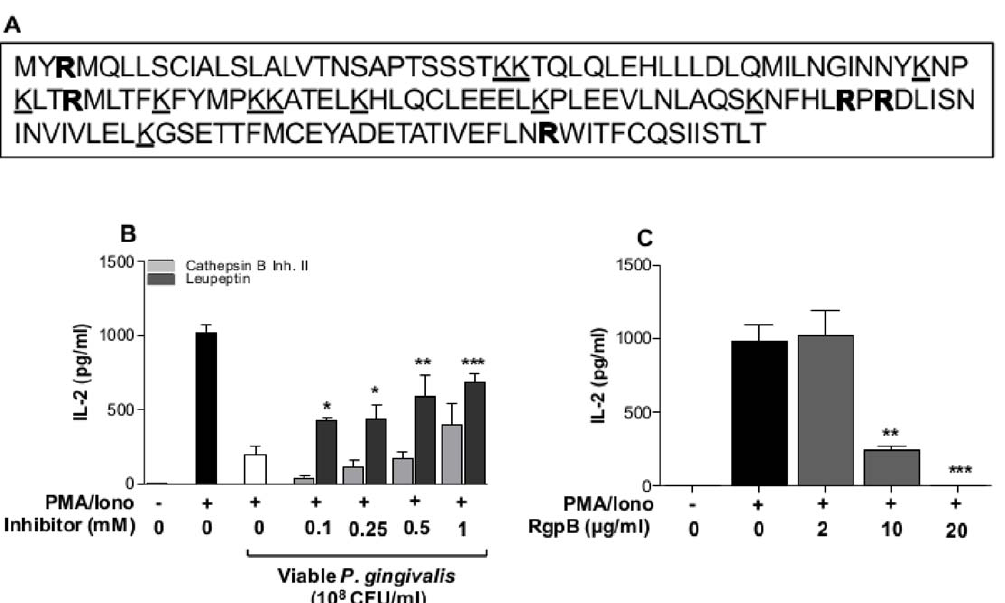
Figure 7. The proteinase inhibitor Leupeptin partially restored IL-2 accumulation. A - IL-2 amino acid sequence with predicted Rgp (bold)- and Kgp (underlined) cleavage sites. Five Rgp sites and 11 Kgp sites were found, source: http://www.ncbi.nlm.nih.gov/CCDS/CcdsBrowse. cgi?REQUEST=CCDS&DATA=CCDS3726. B - The involvement of Rgp and Kgp in IL-2 cleavage was determined by using Cathepsin B inhibitor II and Leupeptin. Viable P. gingivalis were incubated with the indicated concentration for 1 h prior to exposure of cells. Jurkat T-cells (10 6 cells/ml) were pre- treated with 10 8 CFU/ml of viable P. gingivalis (MOI:100) for 1 h followed by stimulated with 50 ng/ml PMA and 1 m g/ml Calcium ionophore for 24 h. IL-2 accumulation was partially restored by Leupeptin, but not by Cathepsin B inhibitor. The asterisks indicate significant differences compared to their respective control (Viable Pg, without Leupeptin). C - Purified RgpB resulted in a dose-dependent inhibition of IL-2 accumulation. The asterisks indicate significant differences compared to the positive control PMA/Iono. *-p , 0.05; **-p , 0.01 (Student’s t